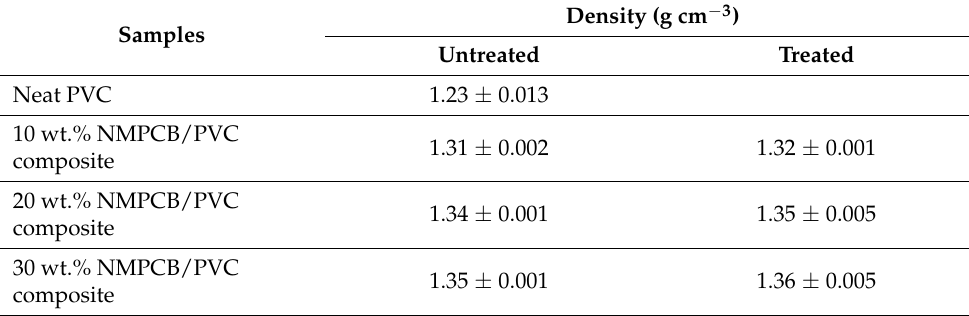
Table 1. Density of untreated and treated NMPCB/PVC